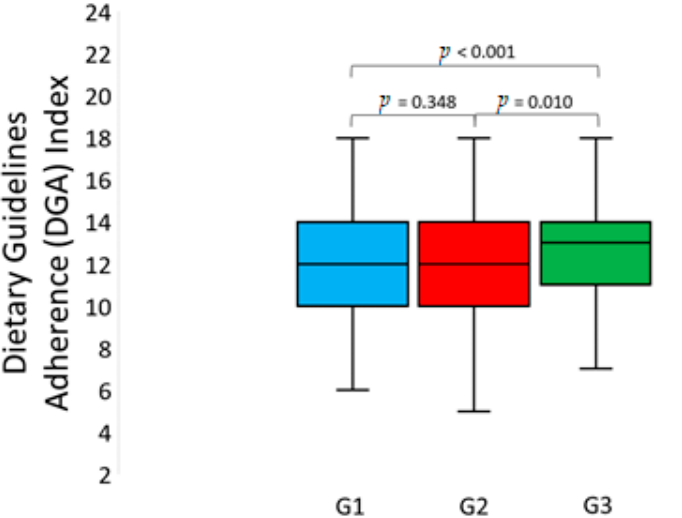
Figure 1. Dietary Guidelines Adherence (DGA) Index in groups with different psychological profiles (one-way ANOVA: F (2, 1079) = 10.104, p < 0.001, eta 2 = 0.018). Table 5. Intergroup comparison of the frequency of consuming individual product groups with different psychological